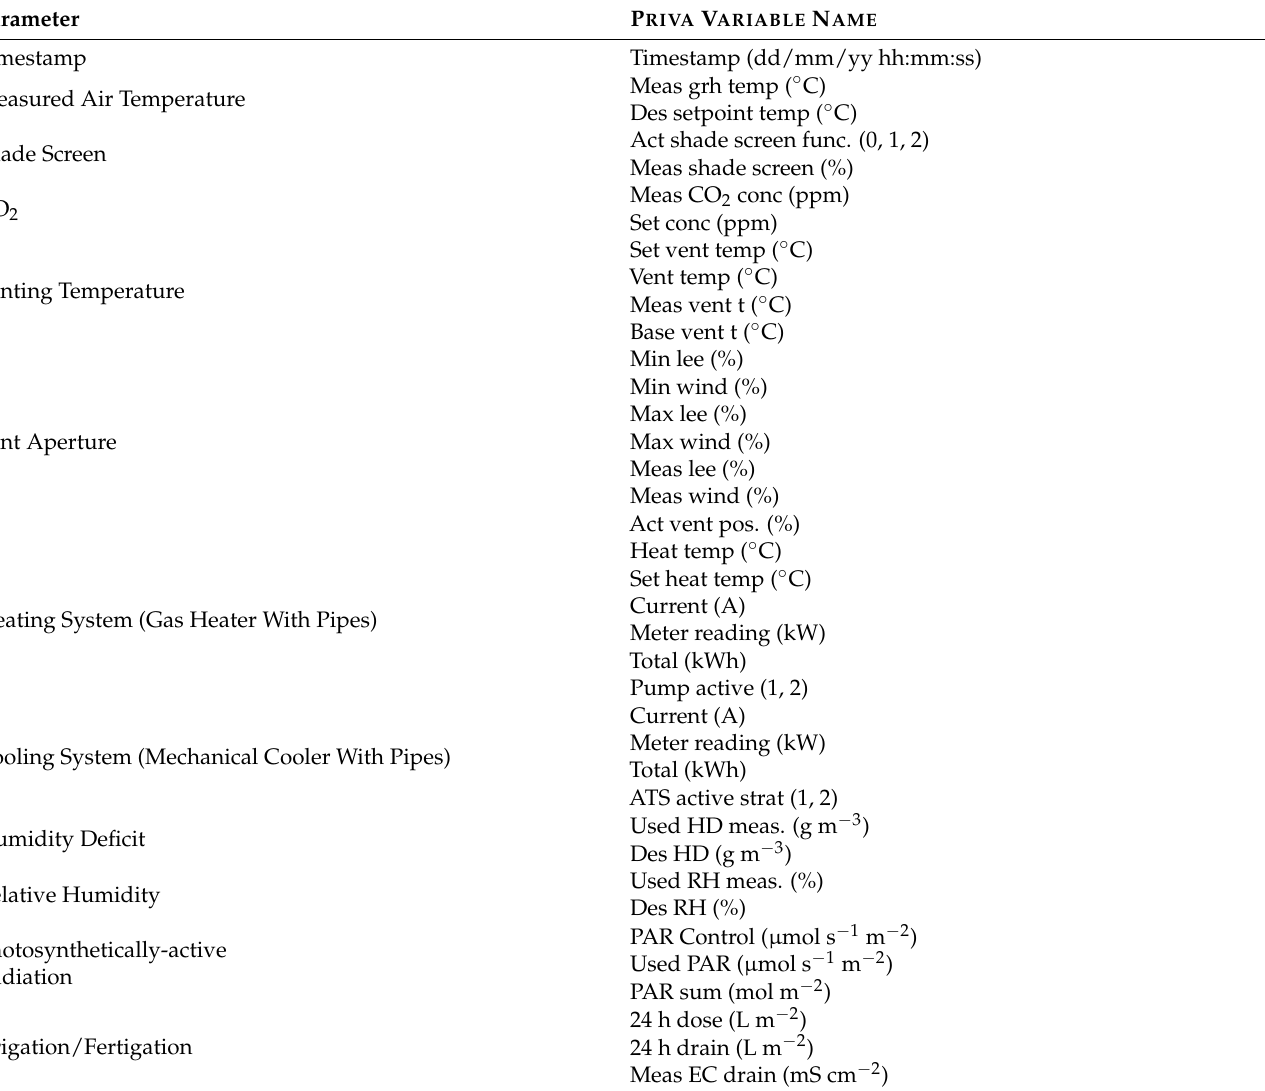
Table A1. List of all parameters controlled by